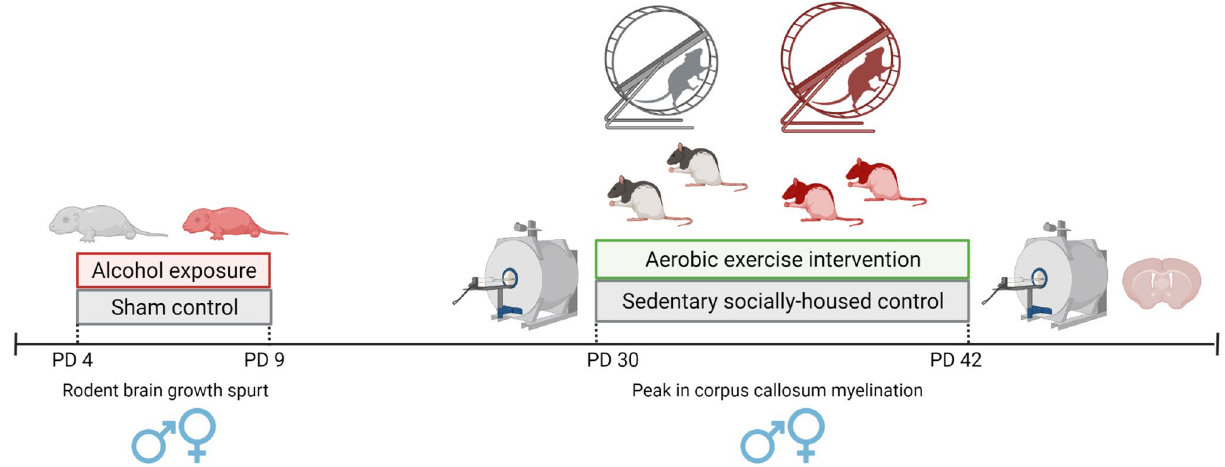
Figure 1. Experimental timeline depicting postnatal treatment (AE/SI) and intervention exposures (WR/SH). Scans were collected twice from each rat pre- and post-intervention. [ Graphic representation of the timeline is created with BioRender.com